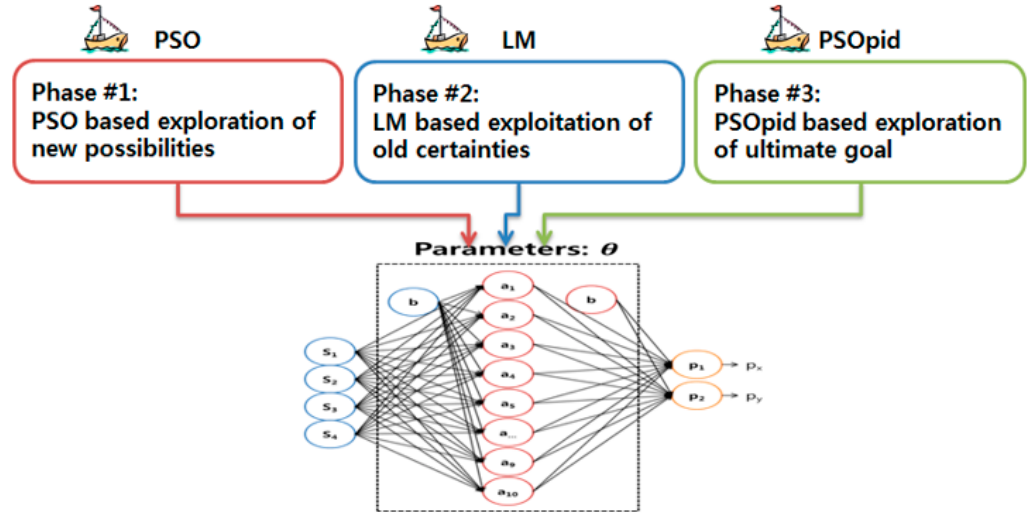
Figure 5. Three-phase hybrid optimization method.